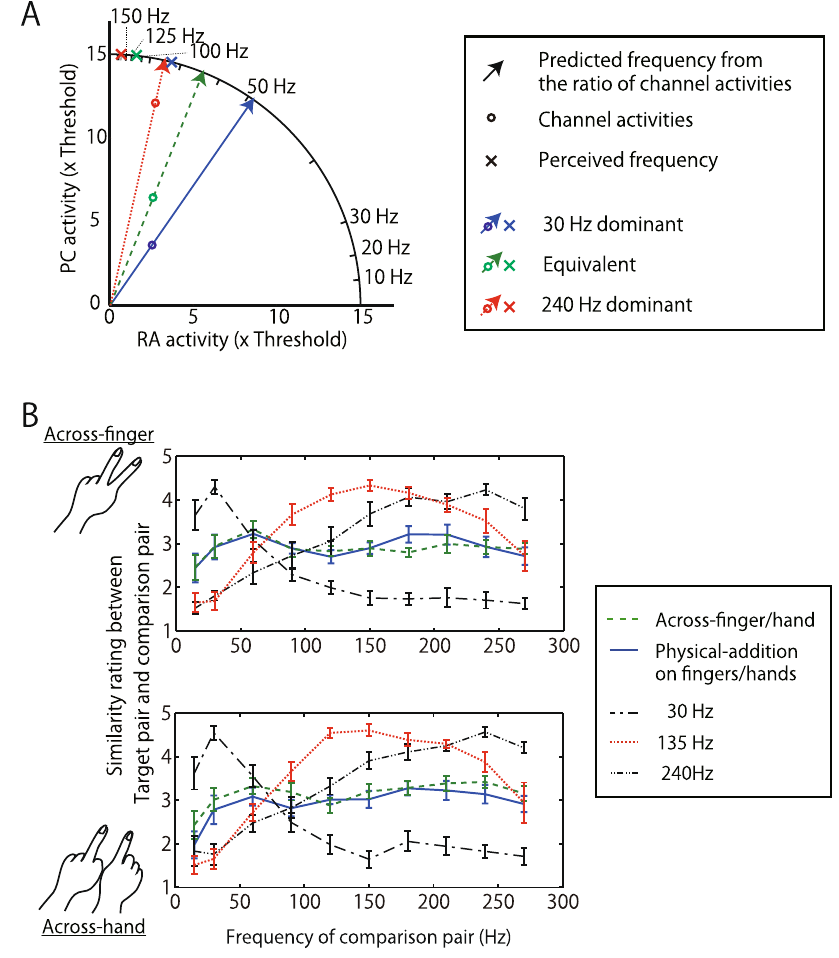
Figure 6. ( A ) Comparison between prediction of the ratio of channel activities and experimental results. Circles represent estimated channel activities for original stimuli in experiments based on sensitivity functions in previous research (1–5). Arrows represent predicted frequency from the ratio of RA and PC channel activities in the 30 Hz-dominant condition (blue arrow), Equivalent condition (green dashed arrow), and 240 Hz- dominant condition (red dotted arrow). These predicted frequencies are plotted as black crosses in Fig. 4B. Crosses represent matched/perceived frequencies in experiments, where each color represents each condition. ( B ) Similarity rating of the target pair and pair of sine-wave vibrations. Participants rated the similarity from 1 (dissimilar, easily-distinguishable) to 5 (very similar, indistinguishable). Note that 135 Hz (Red dotted line) is the weighted average of 30- and 240-Hz vibrations, though the rating distribution of this condition is far different from that of the target pair of Across-finger/hand or Physical-addition. N = 8. Error bars indicate ± 1